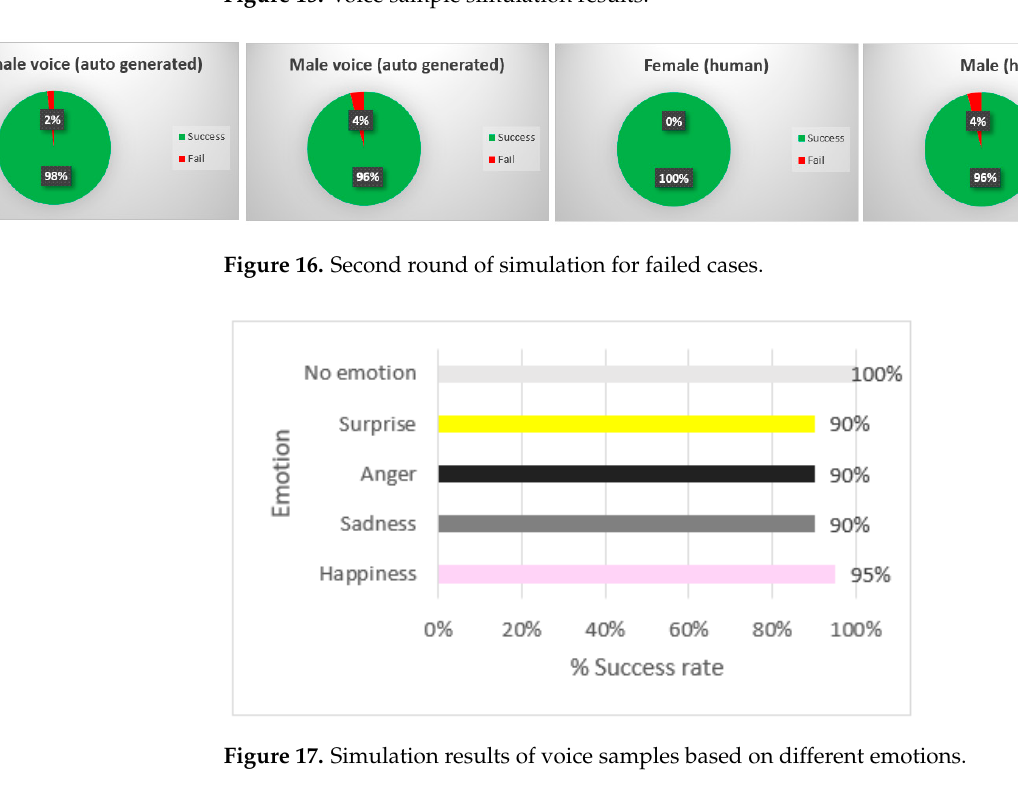
Figure 18. Simulation results of voice samples based on various sound frequencies.